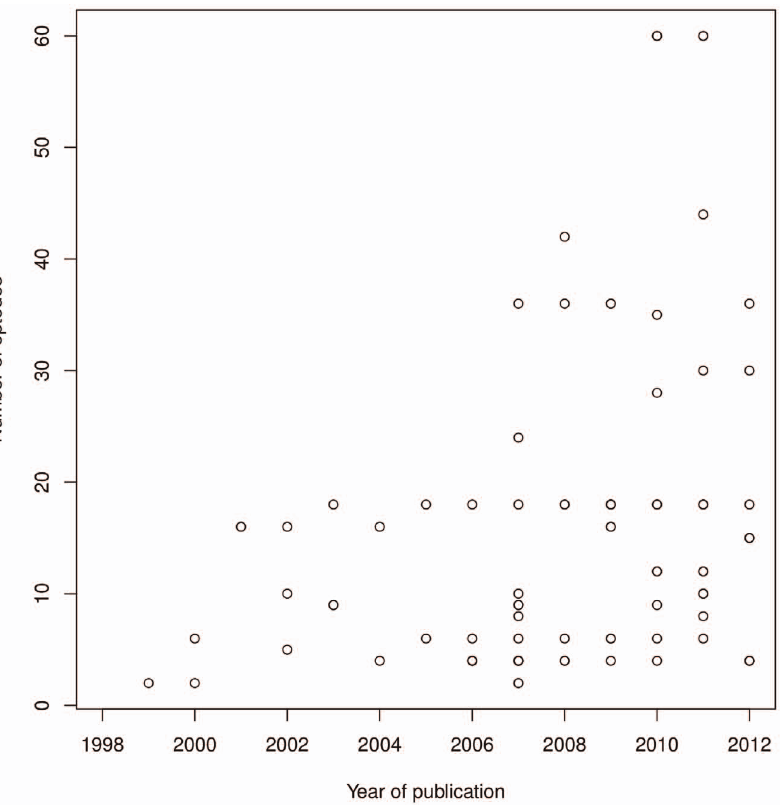
Figure 2. Number of optodes as a function of year. Number of optodes is totaled over sources and detectors.